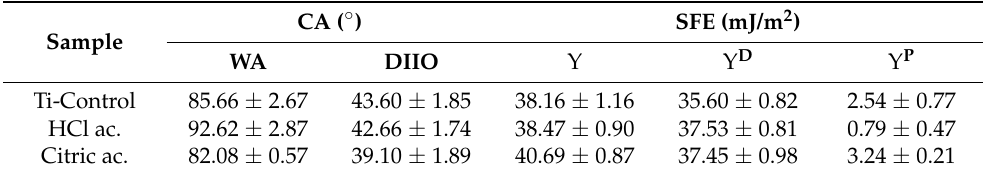
Figure 2. Roughness parameters: ( a ) average roughness (Sa) and ( b ) surface area index (S A Index ). Table 3. Values (mean ± standard deviation) of contact angle of water (WA) and diiodomethane (DIIO), and the estimated surface energy ( Υ ) with their polar ( Υ P ) and dispersive (B3; D ) components, for each surface